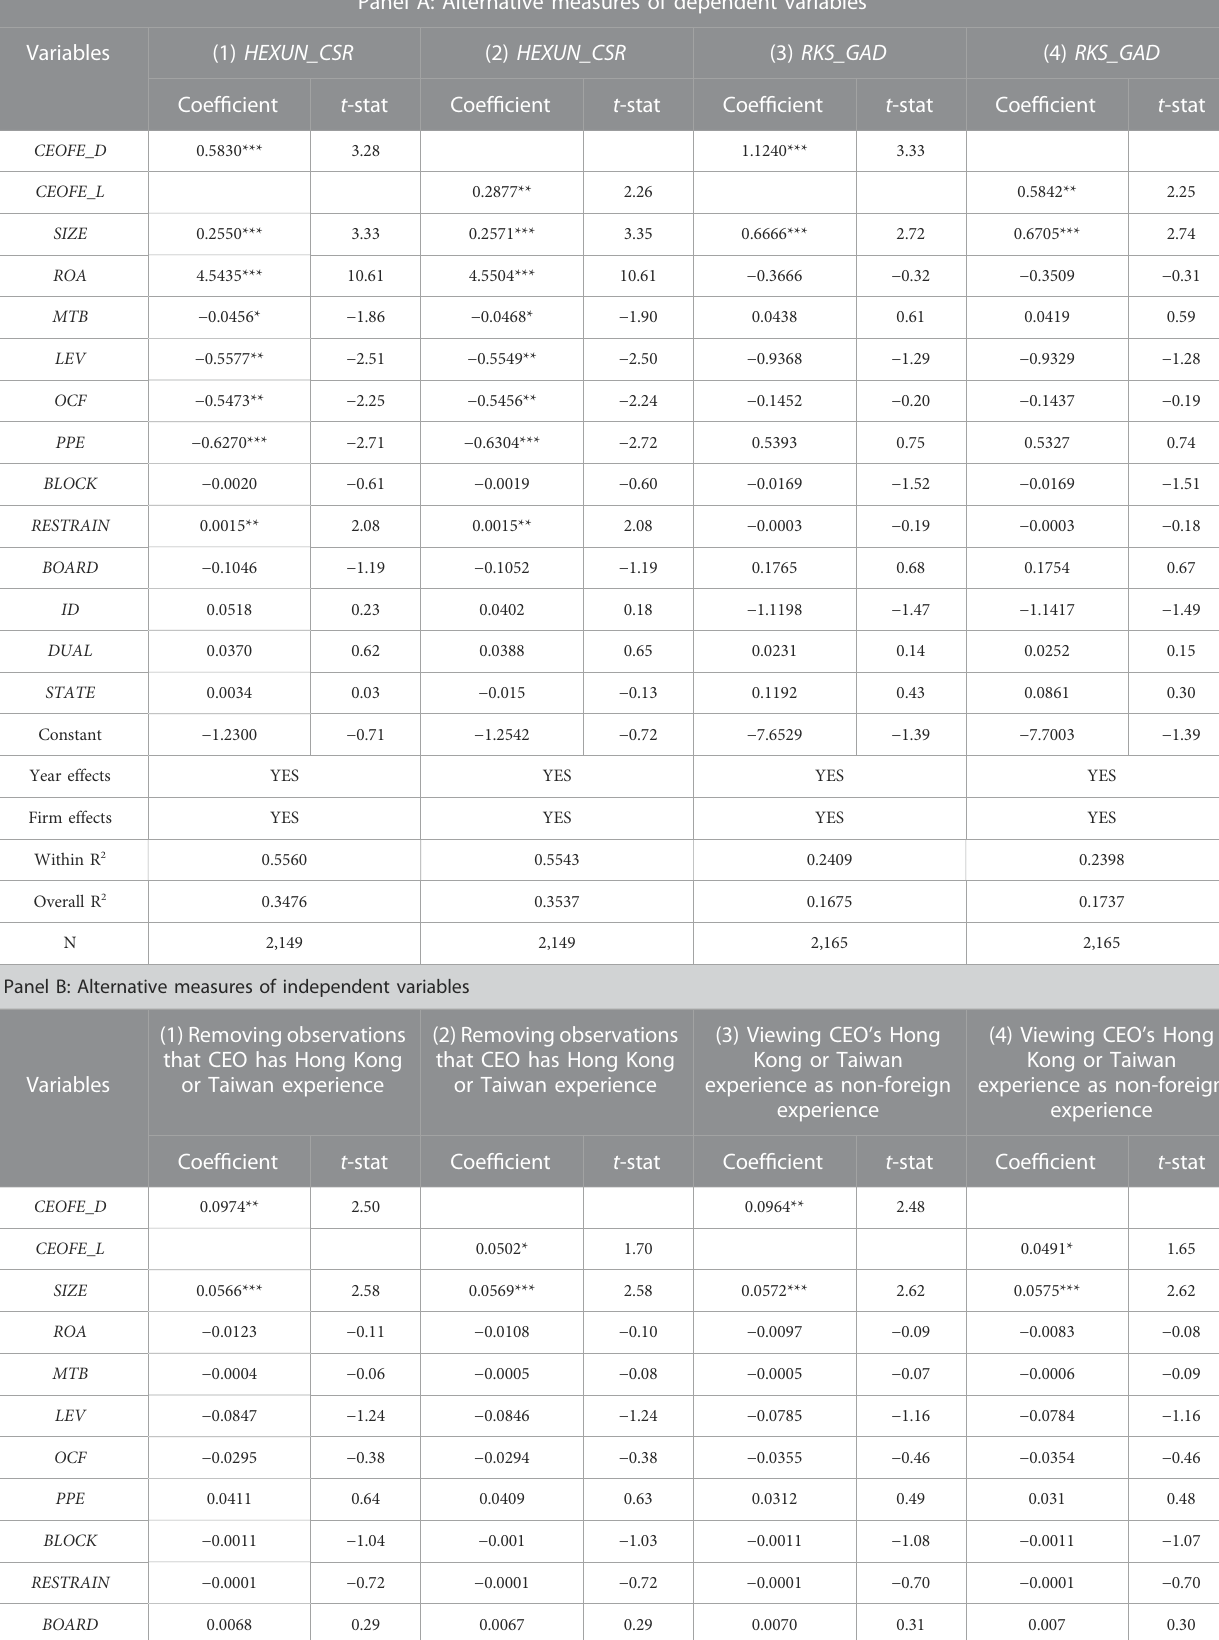
TABLE 9 CEO ’ s foreign experience and CSR (Alternative measures of dependent and independent variables). Panel A: Alternative measures of dependent